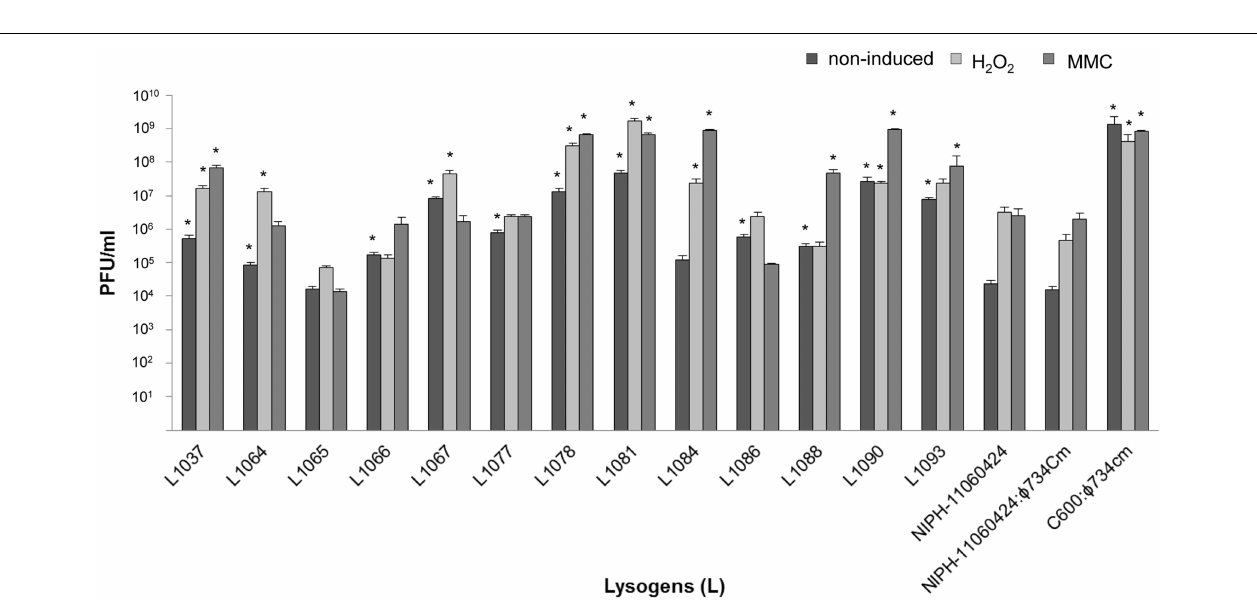
FIGURE 2 | Bar chart showing Stx2-phage production by NIPH-11060424, NIPH-11060424: φ 734Cm, C600: φ 734Cm and 13 commensal E. coli φ 734Cm lysogens under non-induced, MMC induced or H 2 O 2 induced conditions. The error bars represent the